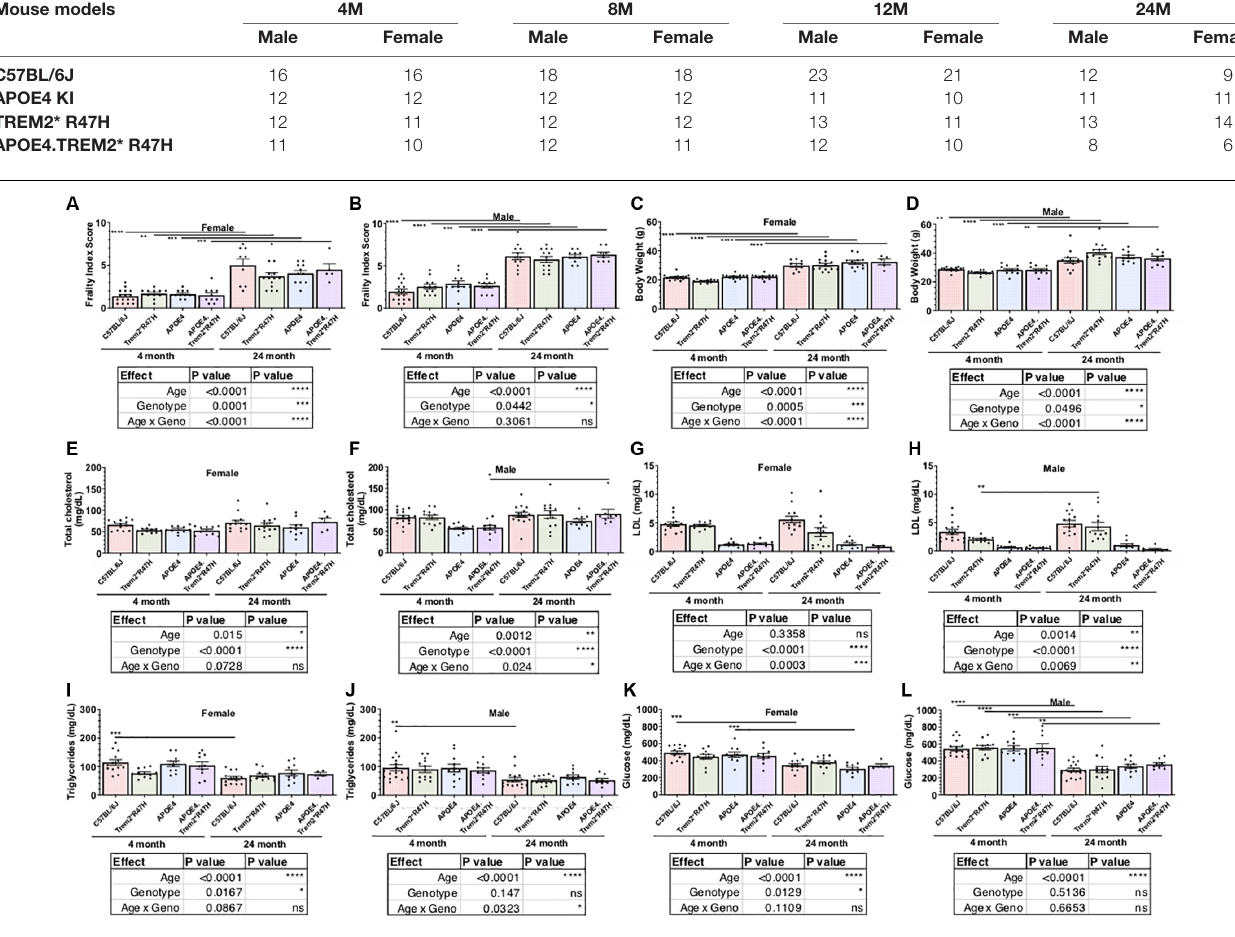
TABLE 2 | Frailty assay and behavioral assays study population. Mouse